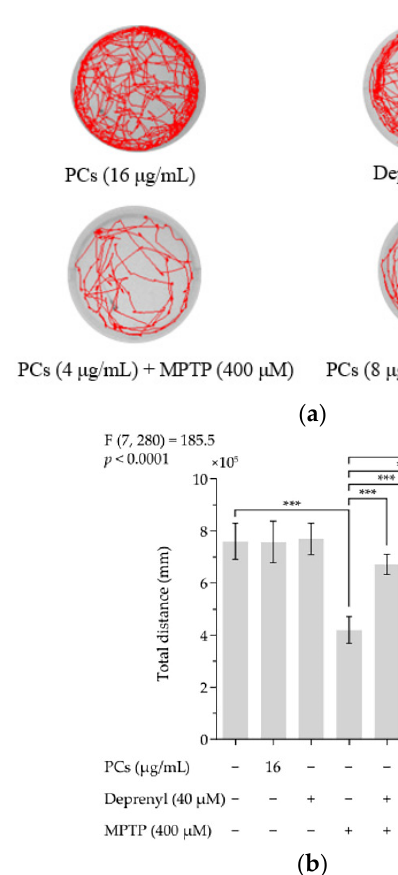
Figure 5. Effects of PCs on zebrafish larvae motility upon MPTP treatment. ( a ) Typical patterns of swimming traces of zebrafish larvae in each group; ( b ) Average total distance of zebrafish larvae in each group. F and p values of the one-way analysis of variance are presented above the chart. The results of Tukey’s post hoc test are presented for selected comparisons: ***, p < 0.001; the error bars are SD.